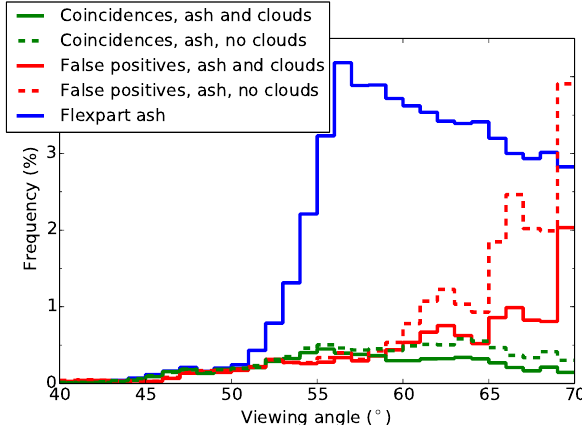
Figure 9. Ash detection as a function of viewing angle for the Eyjaf- jallajökull (2010) eruption: the frequency of pixels identified as ash in the Flexpart simulations (blue line), false positive pixels from ash detection (red line) and coincidences (green line). Solid (dashed) lines represent cloudy (cloudless)